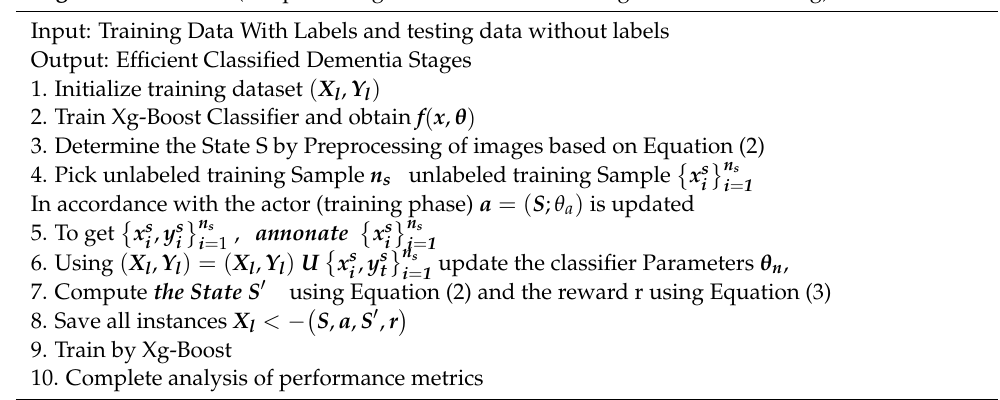
Algorithm 1 . DRLA (Deep learning Reinforcement Learning for Active